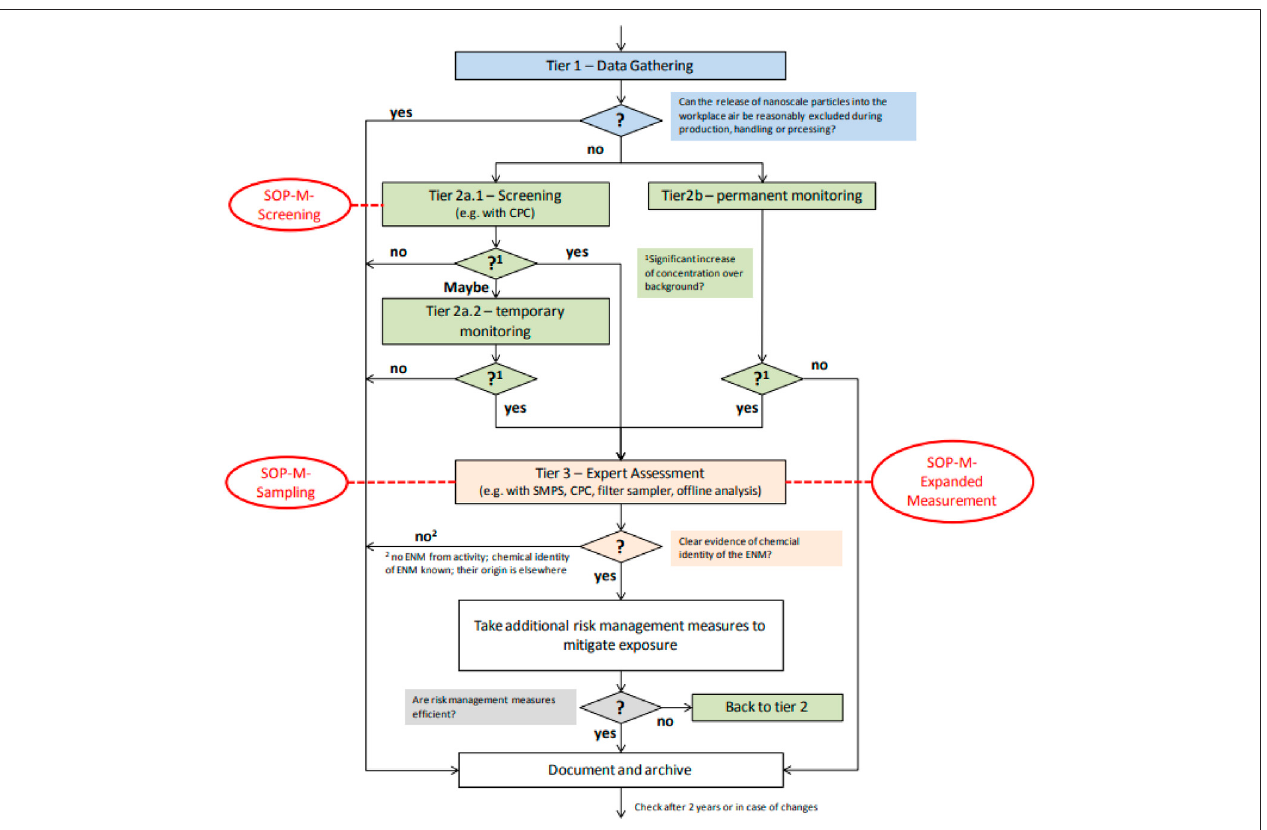
FIGURE 2 | Tiered approach process fl ow (Kuhlbusch et al.